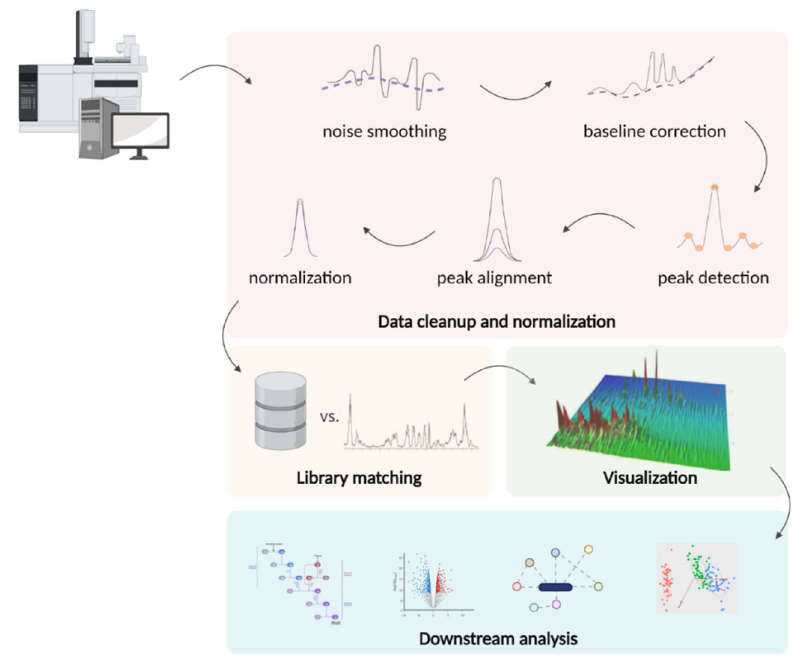
Figure 6. Typical steps in the processing of GC ‐ MS metabolomics data: noise filtering, baseline correction, peak detection, and normalization. The filtered data obtained after preliminary processing is compared with the spectral libraries. The resulting array of annotated spectra can be visualized and used in further statistical algorithms to build biological models.